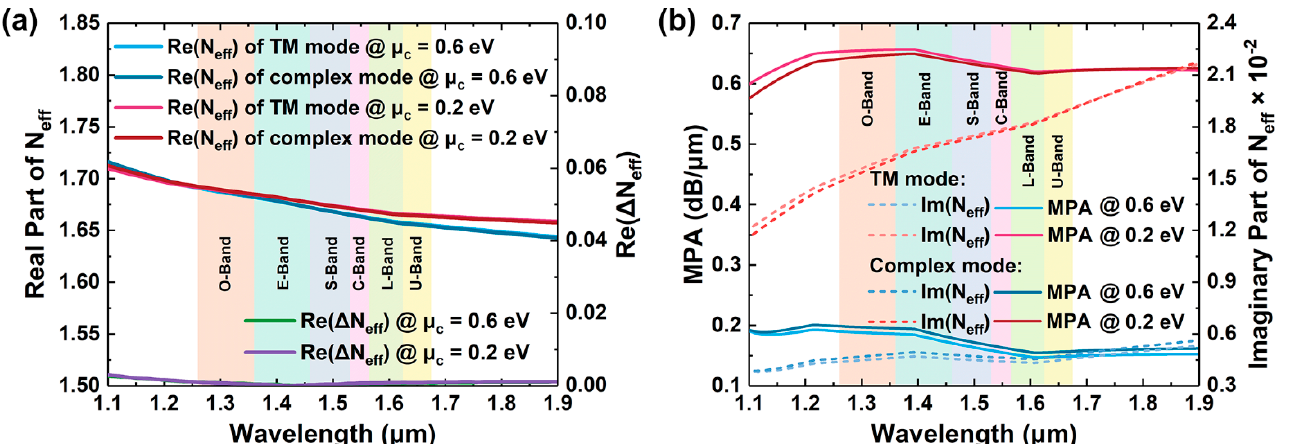
Figure 12. (a) Re( N eff ) and Re( Δ N eff ), (b) Im( N eff ) and MPA of the TM mode and complex mode versus the incident wavelength at µ c = 0.2 and 0.6 eV, respectively.